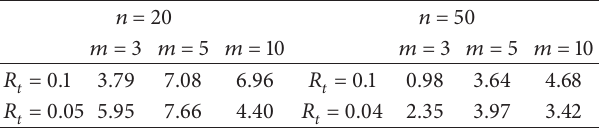
Table 7: Comparing IS with the DSJF %.